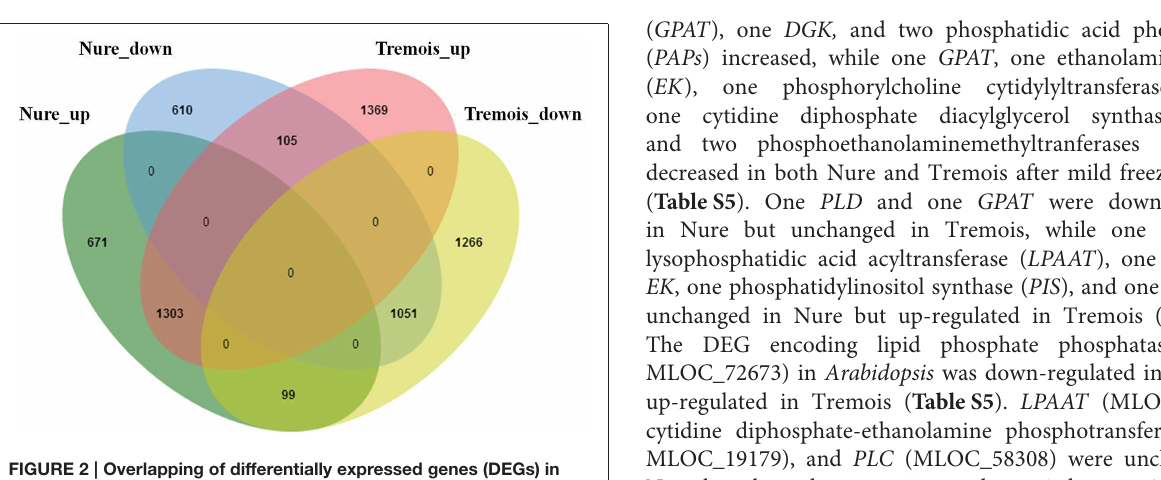
FIGURE 2 | Overlapping of differentially expressed genes (DEGs) in Nure and Tremois after freezing shock. Nure_up, DEGs up-regulated in Nure. Nure_down, DEGs down-regulated in Nure. Tremois_up, DEGs up-regulated in Tremois. Tremois_down, DEGs down-regulated in Tremois.